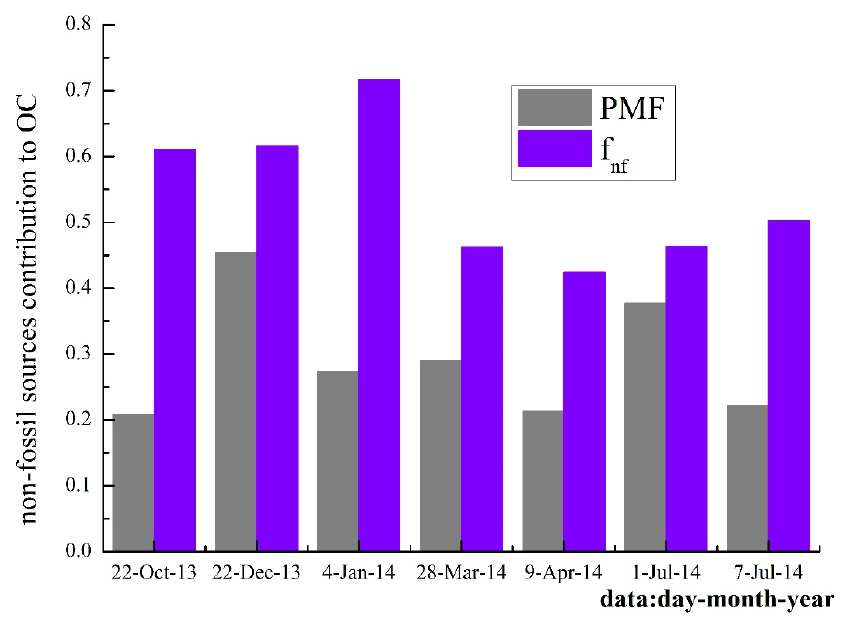
Figure 7. Non-fossil source contributions of OC after secondary aerosol subdivision and the corresponding 14 C fractions.